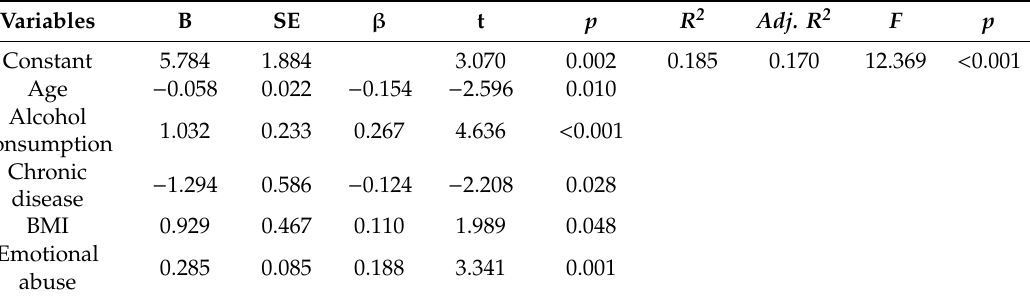
Table 4. Factors A ff ecting Sleep Quality ( n =